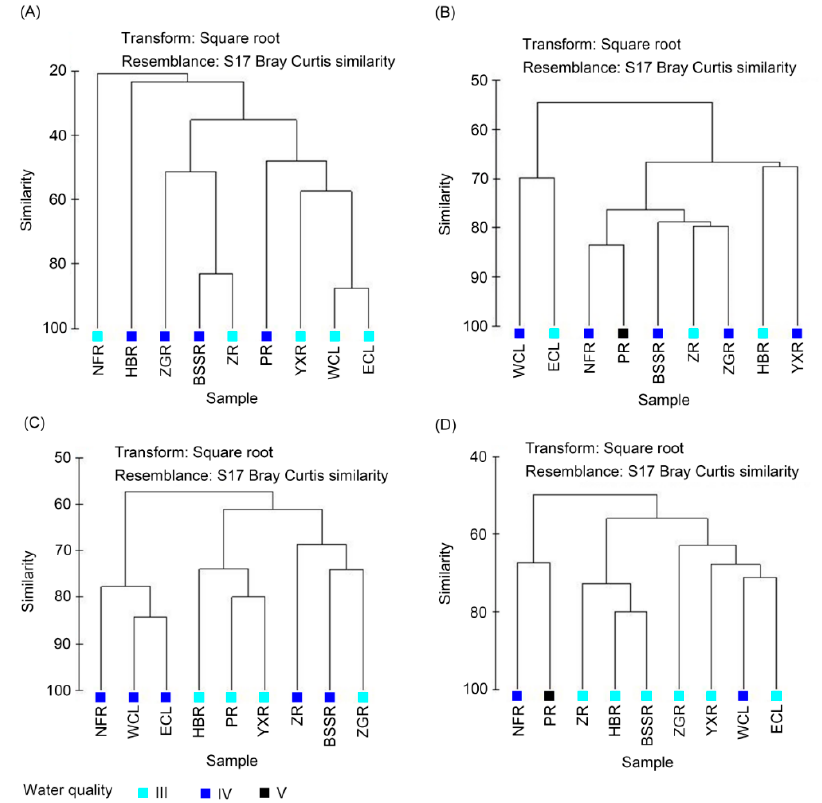
Figure 5. Clustering profiles of zooplankton functional groups based on their density. ( A ) spring, ( B ) summer, ( C ) autumn, and ( D ) winter.